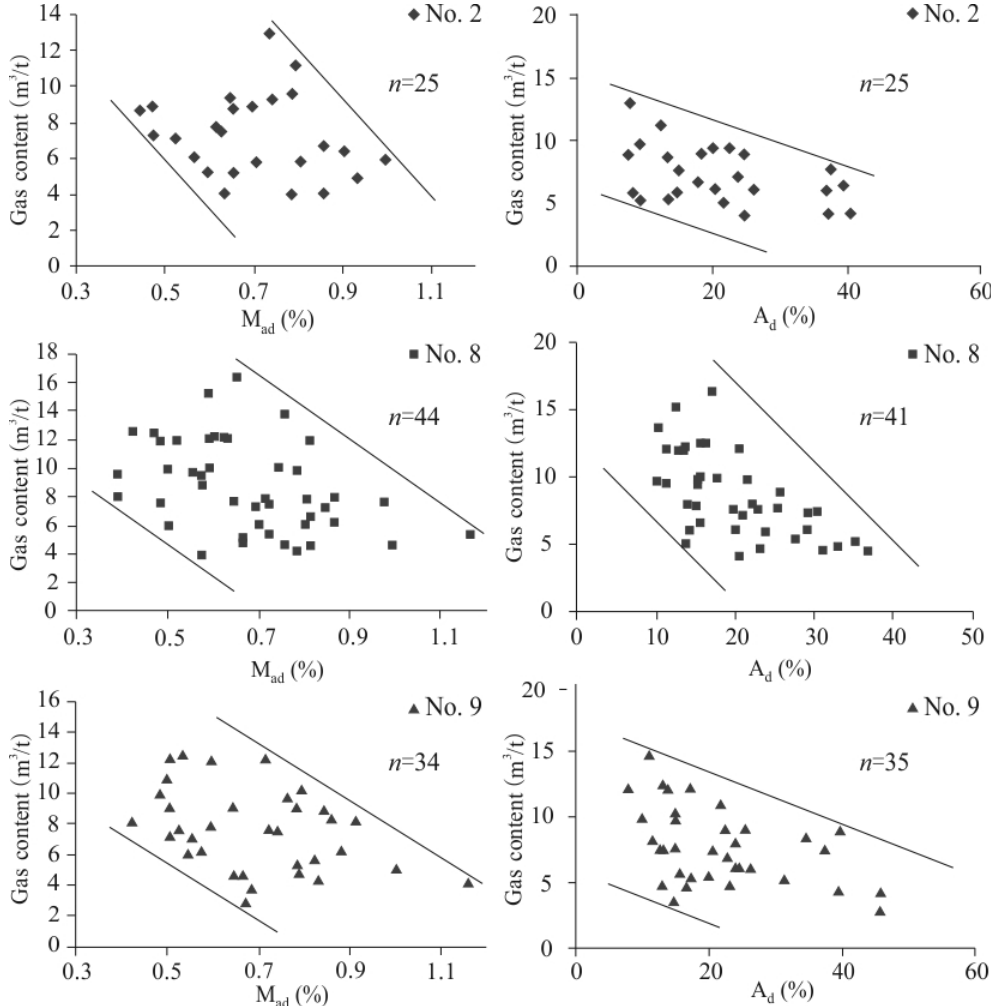
Figure 12. Decreasing trends of gas content with the increase in moisture content (M ad ) and ash yield (A d ) for Nos. 2, 8, and 9 coal seams in the Gujiao area.